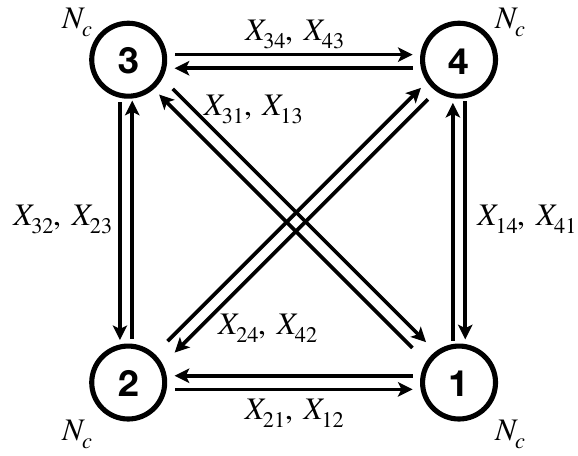
Figure 1 . Quiver for the toric phase of C 3 / Z 2 × Z 2